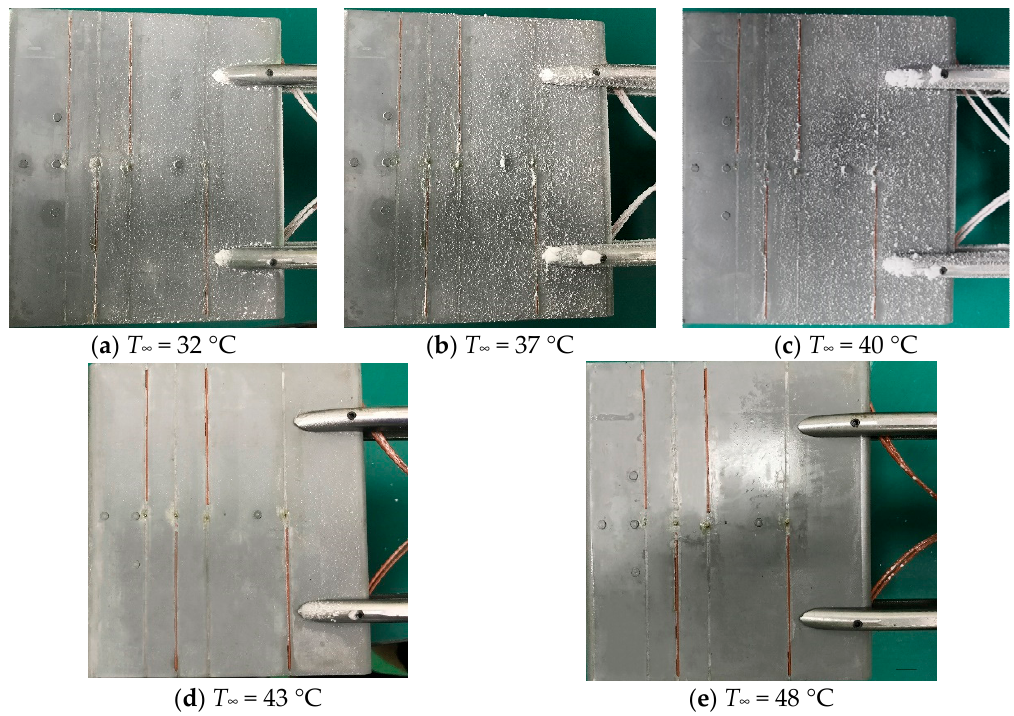
Figure 15. Photographs of wax deposition on windward surface with different mainstream temperatures.